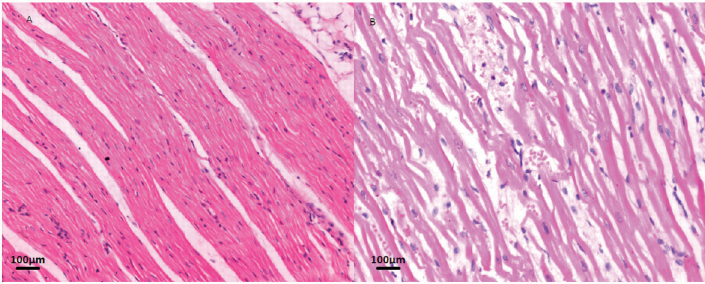
Figure 1. Representative heart sections from control ( A ) and pacing ( B ) dogs obtained by light microscopy. Panel B shows disorganized struc- tures: disrupted myocardial transverse striations, wave-like arrangements of cardiac muscle fibers, dissolved and necrotic cell cytoplasm, mesenchy- mal blood vessel dilatation and congestion, erythrocyte leakage, and small inflammatory cell infiltration, which did not occur in the control group.